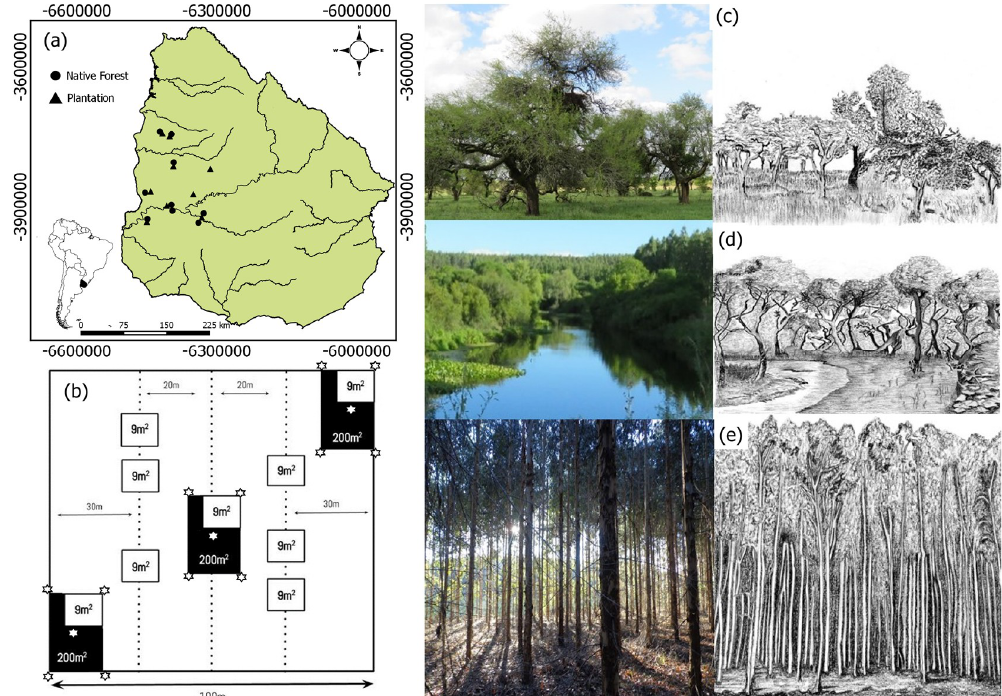
Figure 1. Map of the study area with: ( a ) the study sites in the northwestern part of Uruguay (black dots: native forests and black triangles: Eucalyptus plantations); ( b ) sampling design composed of permanent plots (100 × 100 m 2 ), inventory plots for trees (20 × 10 m 2 ), regeneration subplots (3 × 3 m 2 ) and measurement points of LAI (leaf area index) showed in asterisks. Examples for forest-type structures; ( c ) park forest characterized by disperse trees growing in a dense herbaceous cover, the figure shows Vachellia caven “espinillo” (Department of Paysandú); ( d ) riverine or gallery forest, forming a narrow dense vegetation strip of shrubs and trees along the river (Department of Río Negro); ( e ) Eucalyptus grandis plantation (Department of Durazno); Coordinate system UTM zone 21 S.